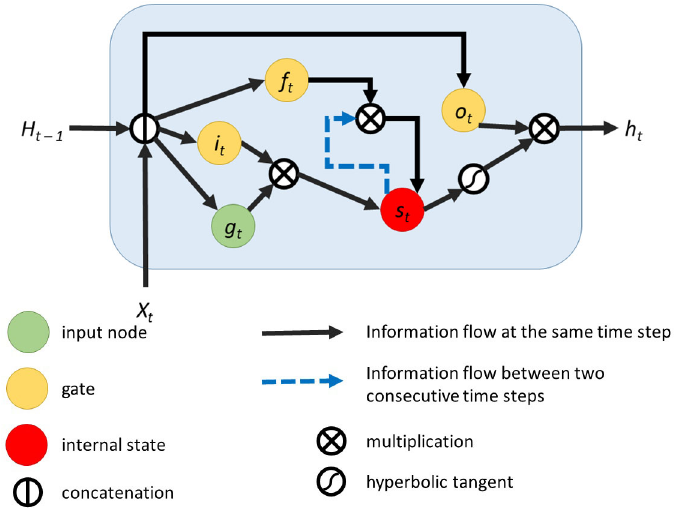
Figure 3. Long short-term memory cell.